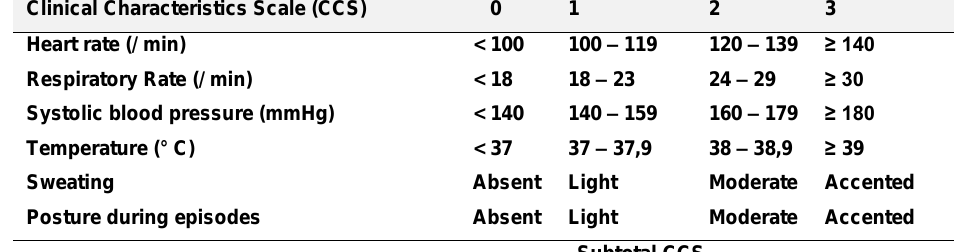
Table 1 - Paroxysmal Sympathetic Hyperactivity Assessment Measurement Clinical Characteristics Scale